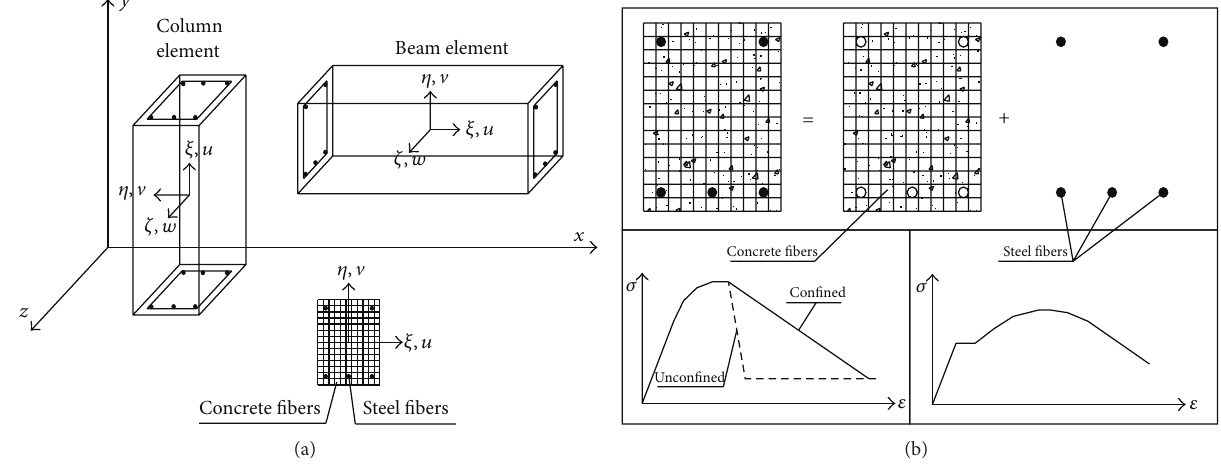
Figure 1: Concrete and steel fibers and global and local axes for FBEA.